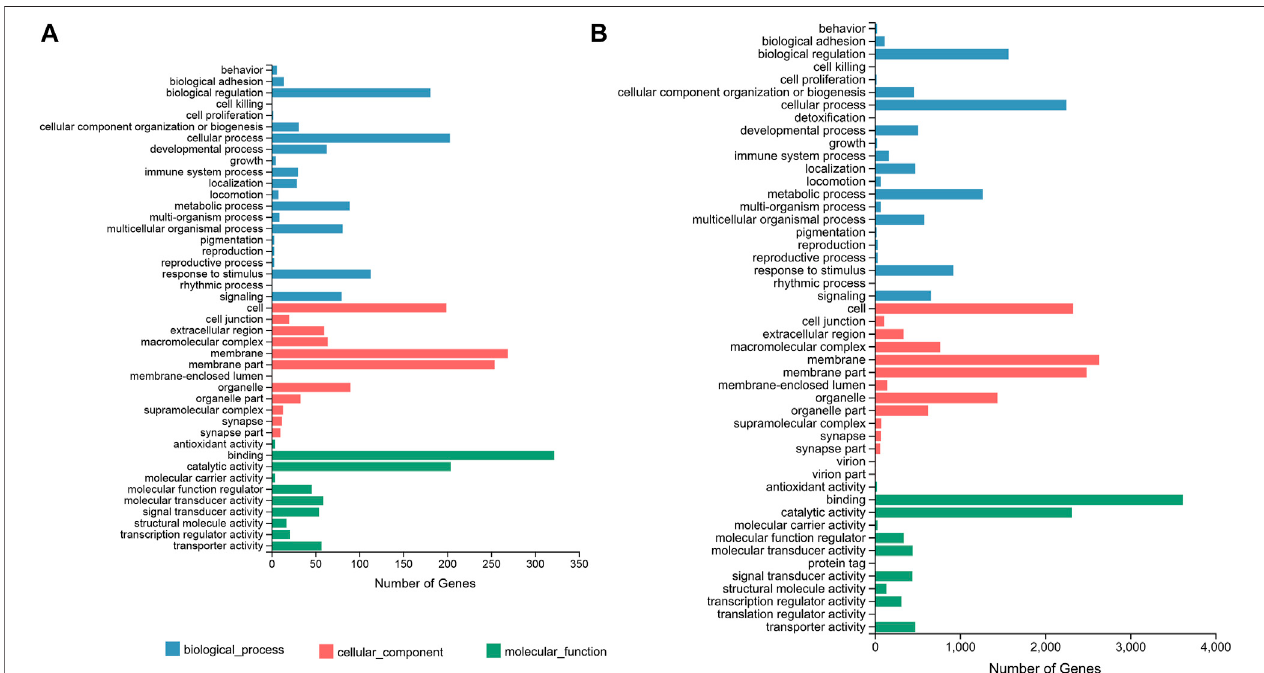
FIGURE1| GOclassi fi cationbasedontheDEGsoftheF_brain-vs-M_braingroup (A) andtheF_sex-vs-M_sexgroup (B) .Thehorizontalaxisshowsthenumberof DEGs enriched in each GO term. GO, gene ontology; DEG, differentially expressed gene.